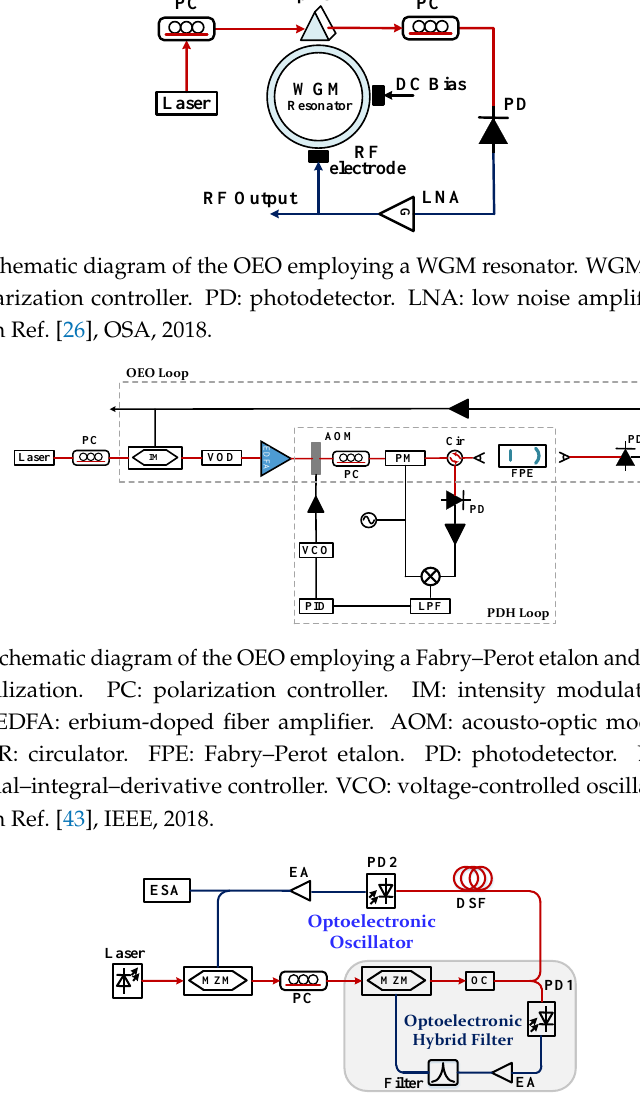
Figure 11. The schematic diagram of the millimeter-wave OEO employing an optoelectronic hybrid band-pass filter with ultra-high Q value. MZM: Mach-Zehnder modulator. PC: polarization controller. OC: optical coupler. DSF: dispersion shifted fiber. PD: photodetector. EA: electrical amplifier. ESA: electrical spectrum analyzer. Reprinted with permission from Ref, [44], IEEE, 2018 .